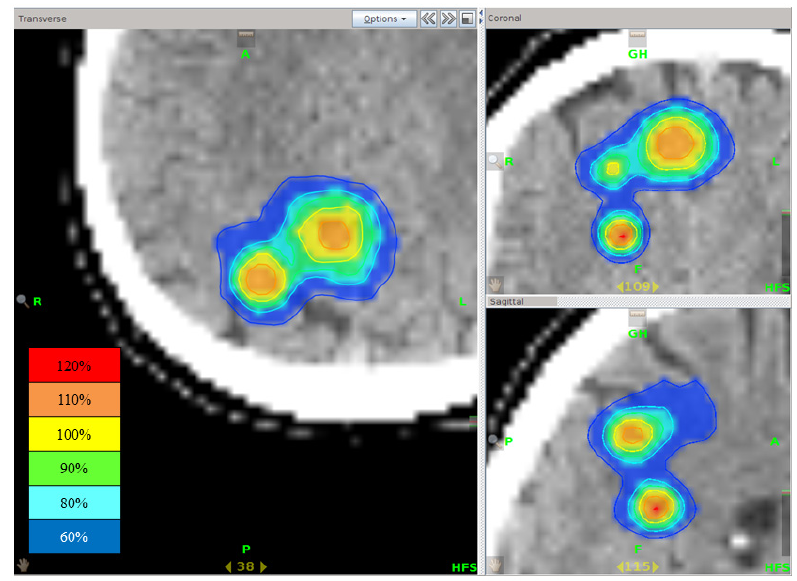
Figure 6. Isodose distribution of stereotactic radiotherapy using tomotherapy for multiple brain metastases. Although three tumors existed close to each other, rapid dose fall outside the PTV was